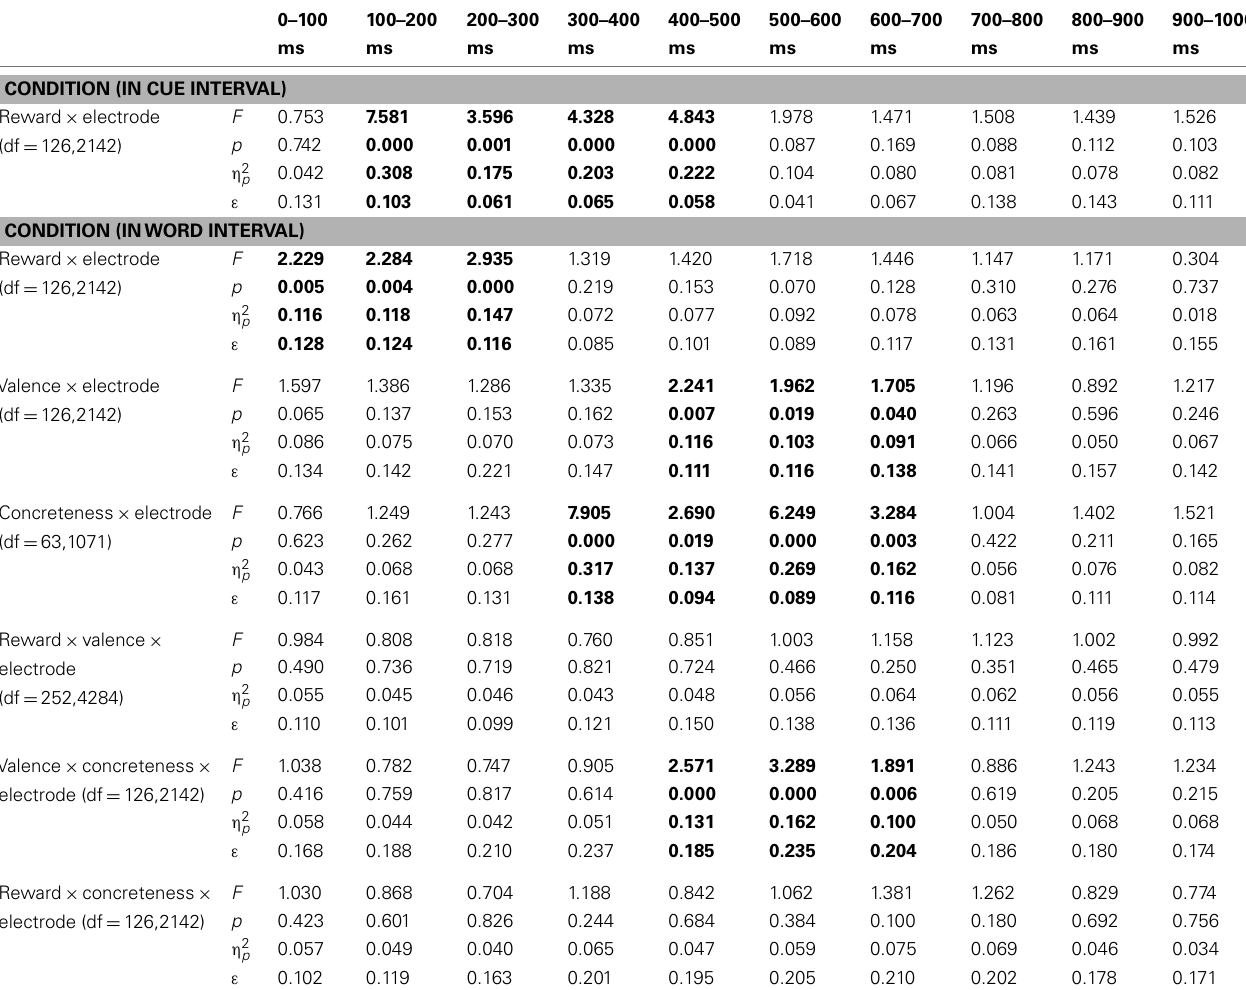
Table 2 | Results of the omnibusANOVAs on mean amplitudes in the cue interval (top) and word interval (bottom) (ms after